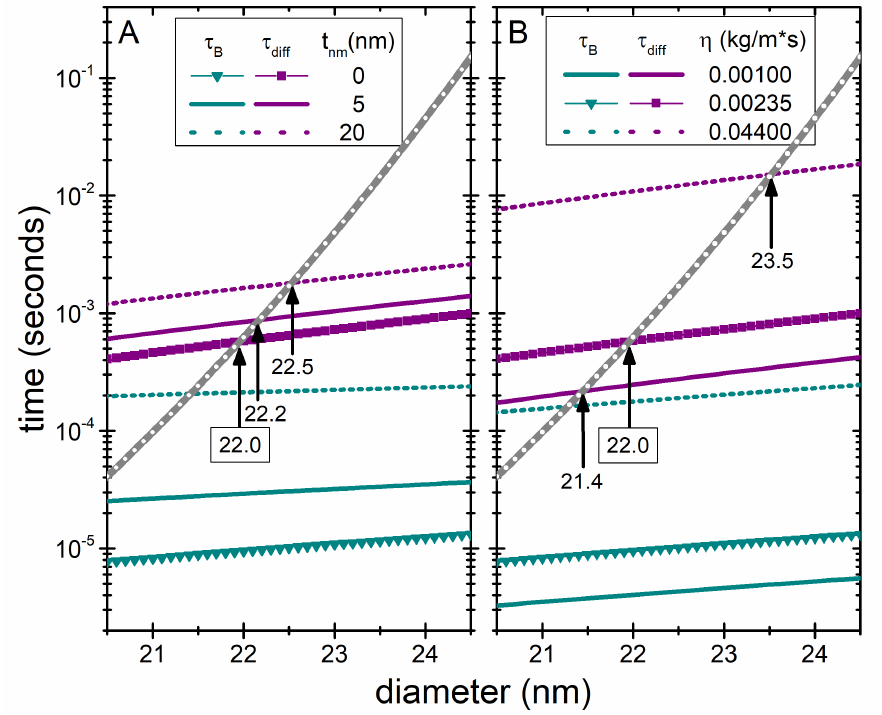
Figure 2. Diffusion ( τ dif f ; purple line), rotation ( τ B ; green line), and Néel relaxation time ( τ N ; grey line), as a function of the particle diameter, as in Figure 1, but considering different thickness of the nonmagnetic coating ( A ), or viscosity of the medium ( B ). For simplicity, the results are focused on the K = 11 kJ/m 3 and the original curves from Figure 1 are reproduced for guidance. The variations of t nm and η are shown with solid and dotted lines, for the values displayed within each panel. The arrows and attached numbers indicate t aggl , with the reference one (22.0 nm)